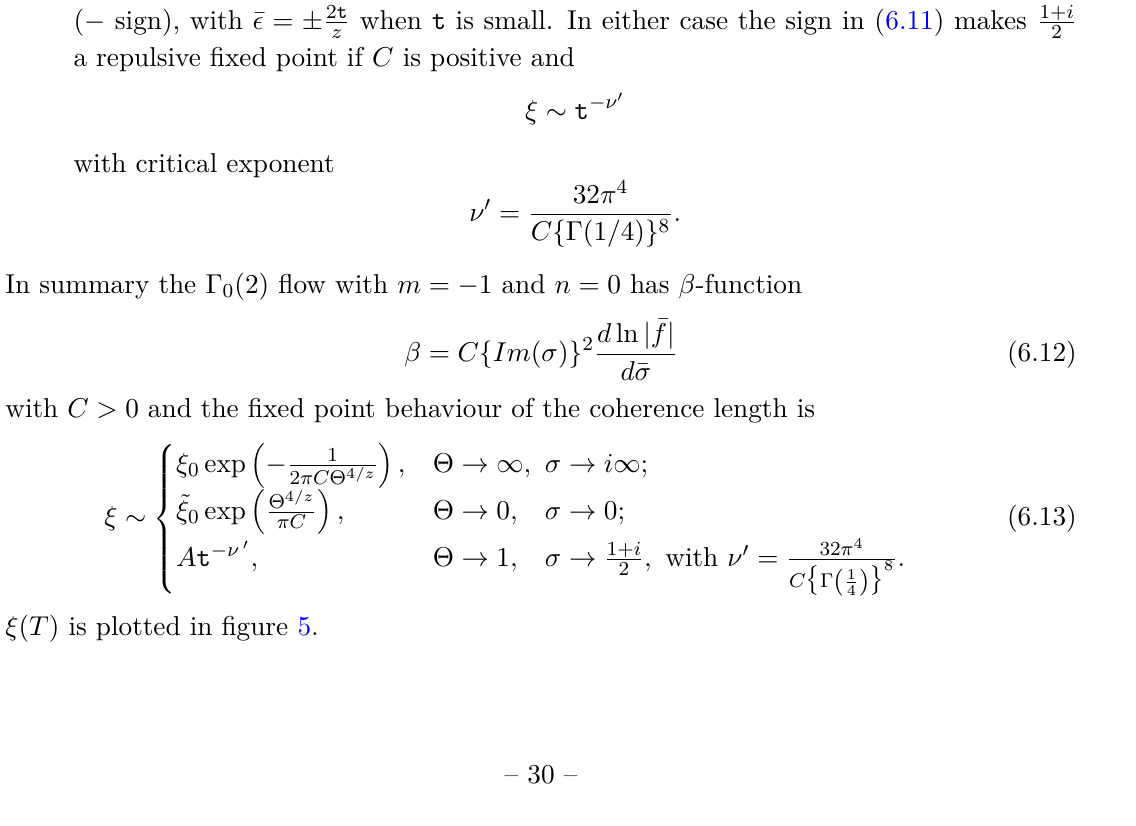
Figure 5 . ξ along the imaginary axis σ = i Θ 4 /z for the purely magnetic solution as a function of Θ 4 /z . Γ (2) symmetry determines the behaviour near Θ = 0 , via (6.13), and (6.12) is numerically 0 integrated to determine ξ (cid:0) Θ 4 /z (cid:1) . The red curve is the numerical result for the specific choice ˜ ξ 0 = C = 1 . The dashed blue curve is the asymptotic form ξ = e Θ 4 /z /π near Θ = 0 and the dashed green curve is the asymptotic value for ˜ ξ Again this assumes that the classical solution gives the correct temperature dependence along the imaginary